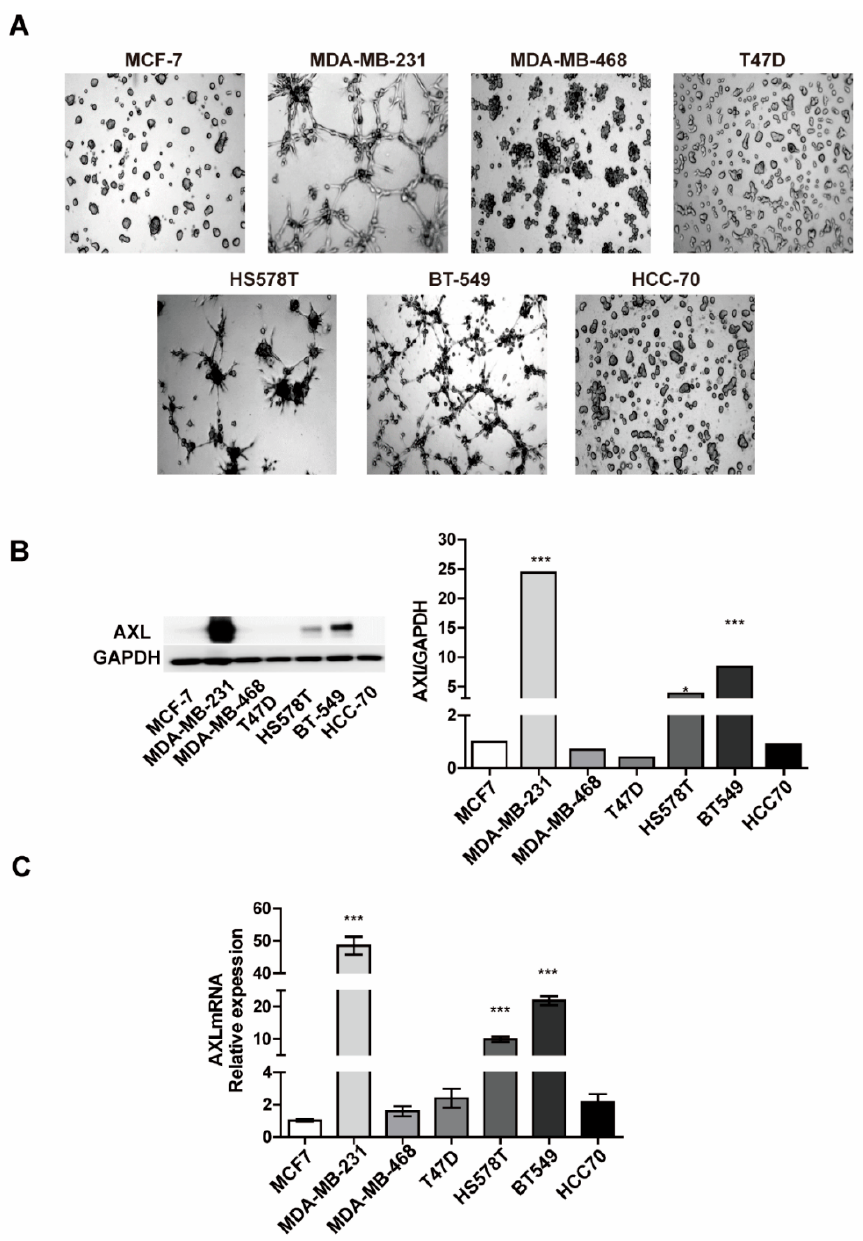
Figure 1. AXL expression is involved in vasculogenic mimicry formation in breast cancer cell lines. ( A ) Vasculogenic mimicry (VM) formation ability in breast cancer cell lines. ( B ) AXL protein expression in breast cancer cell lines. ( C ) AXL mRNA expression in breast cancer cell lines. * p < 0.05, *** p < 0.001 versus controls, calculated using unpaired two-tailed Student’s t -test. Error bars, S.E.M.